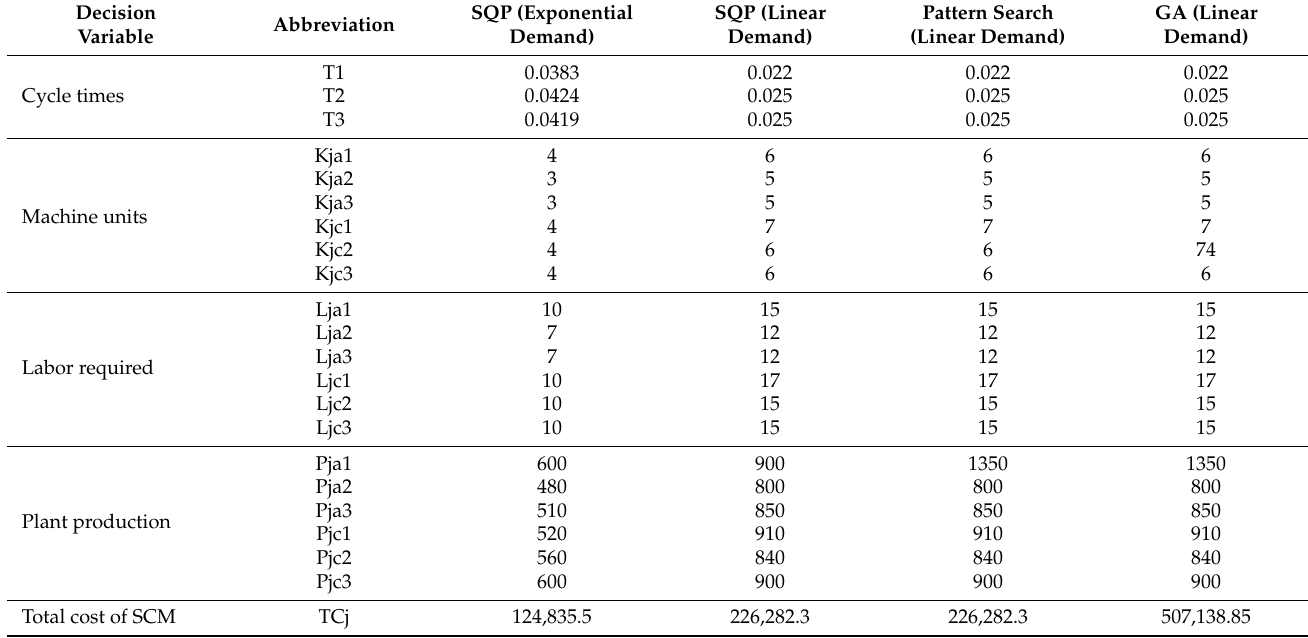
Table 5. The optimal result of the supply chain model with emergency level Ω =